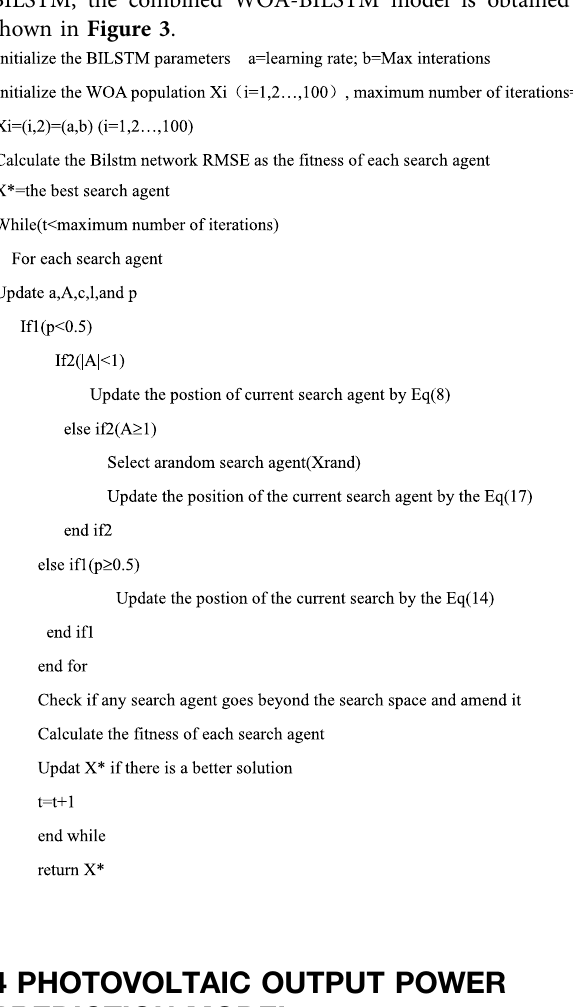
FIGURE 10 | 22 June 2019